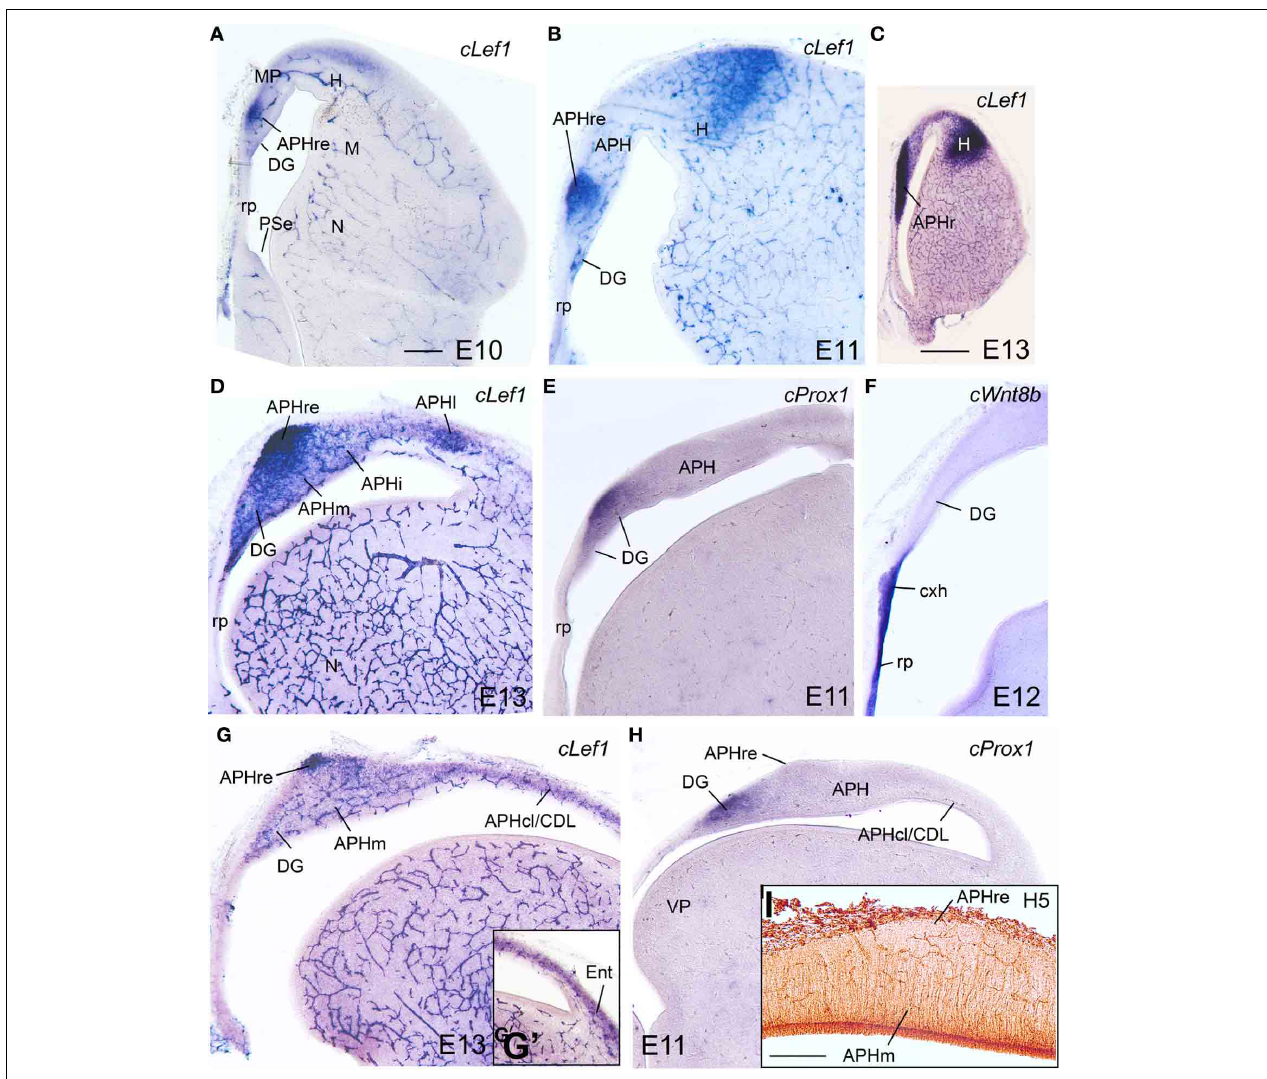
FIGURE 8 | Expression of several genes and radial glial fibers in the chicken embryonic medial pallium at intermediate stages. (A–H) Digital images of coronal sections of chicken embryonic telencephalon (E10–E13), at rostral (A–C) , intermediate (D–F) , or caudal (G–I) levels, hybridized for cLef1, cProx1 , or cWnt8b (the latter is used to distinguish the roof plate and cortical hem) Note the strong expression of cLef1 in the rostral APH, which extends